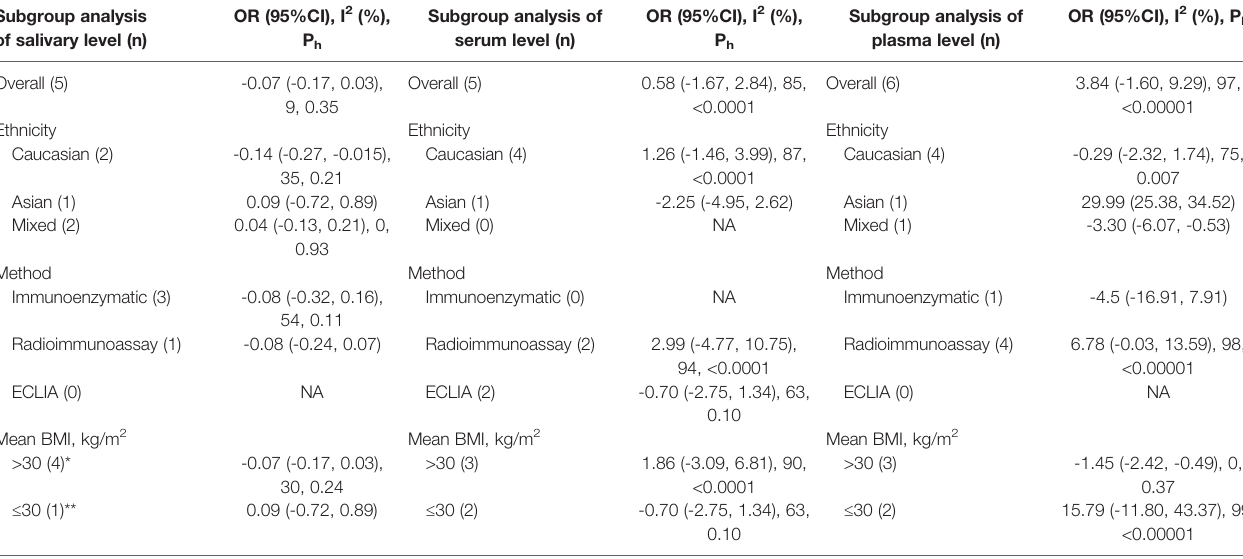
TABLE 2 | Subgroup analysis based on ethnicity and method on salivary, serum, and plasma levels of cortisol in adult obstructive sleep apnea syndrome. Subgroup analysis of salivary level